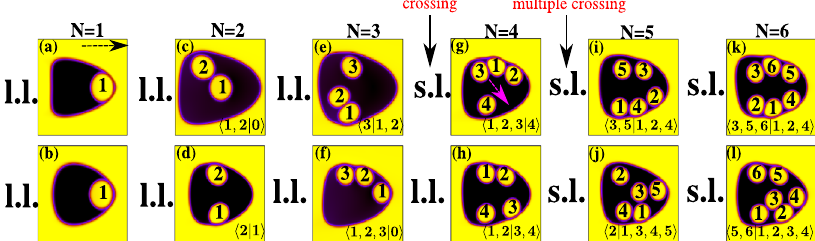
Fig. 3 Nonequilibrium states of multi-core emulsions under Poiseuille fl ow. The dotted black arrow indicates the fl ow direction (which applies to all cases) while N represents the number of cores encapsulated. a Is obtained for Re ’ 3 and Ca ≃ 0.85, while b for Re ’ 1 : 2 and Ca ≃ 0.35. All the other cases correspond to Re ’ 3 and Ca ≃ 0.85. As long as A c < 0.35, the nonequilibrium states are long-lived (l.l.), while if A c > 0.35 they turn into short-lived (s.l.). Here, crossings of cores from one region towards the other one start to occur. The magenta arrow indicates the direction of a crossing. Multiple crossings are observed as A c increases. In each snapshot, states are indicated by means of the occupation number classi fi